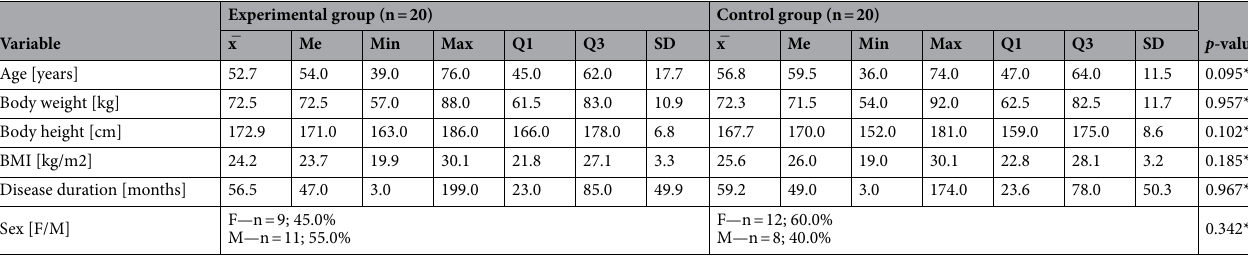
Table 1. Characteristics of study participants. n number of individuals, x ̅ , mean; Me median, Min